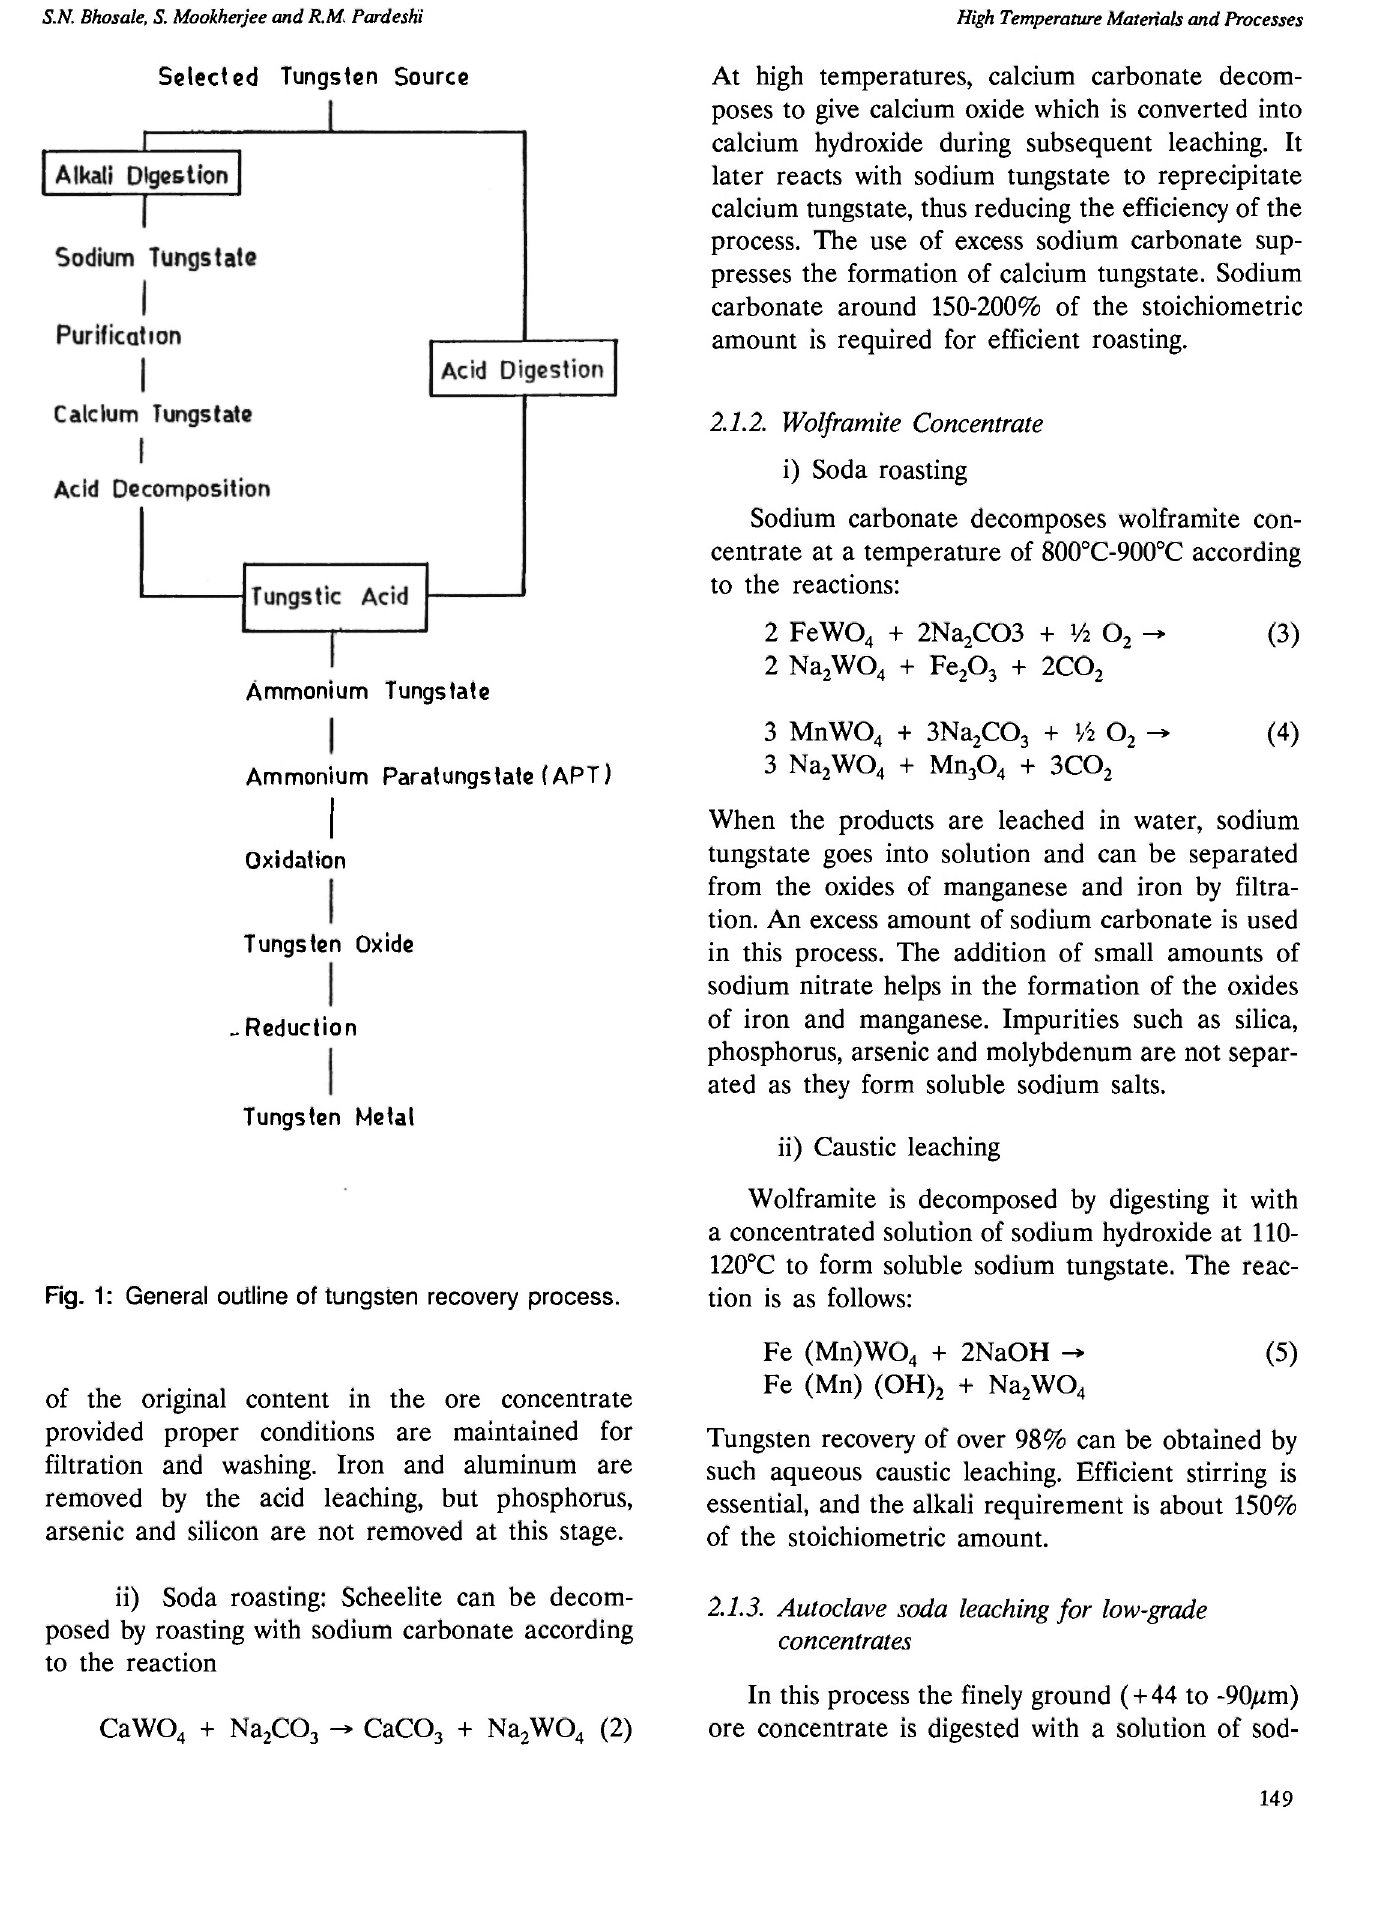
Fig. 1: General outline of tungsten recovery process.